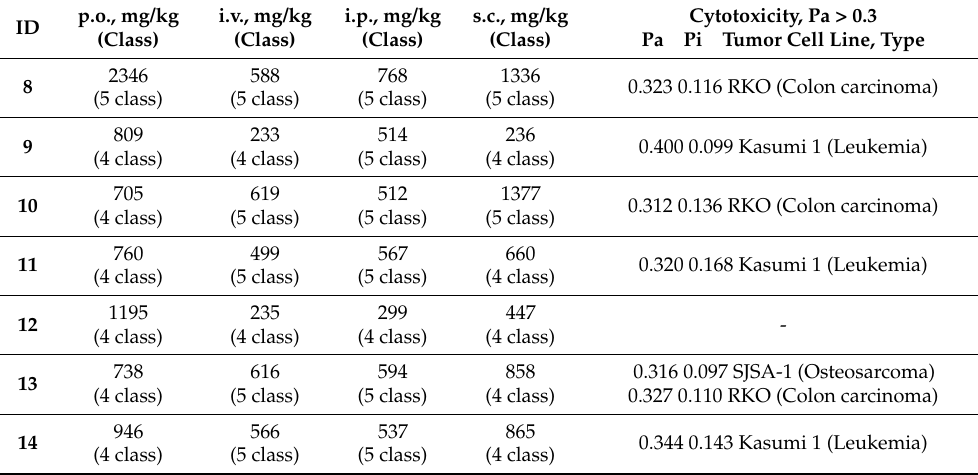
Table 4. Predicted cytotoxicity against human tumor cell lines and acute toxicity (LD50) in rats by different routes of administration for new synthesized compounds.